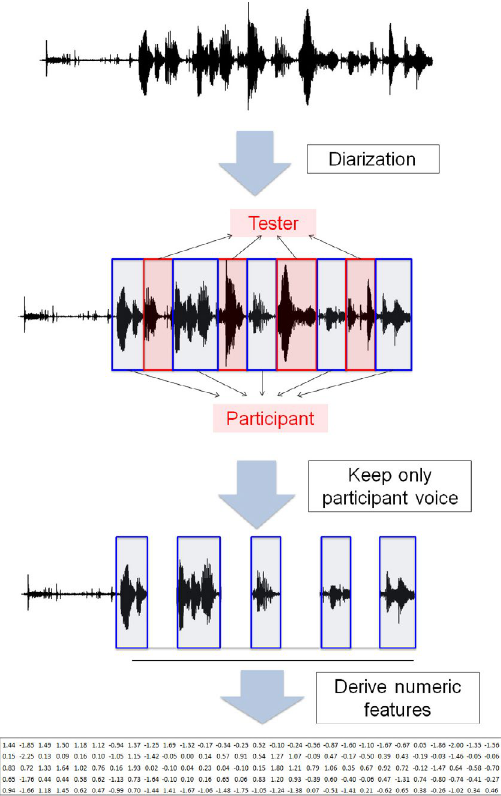
Figure 1. Data preprocessing. The raw voice recording contained the voice from both the tester and the participant. Diarization was performed to remove the voice segments from the tester, and keep only the voice segments from the participants. OpenSMILE was then used to derive numeric features from voice segments